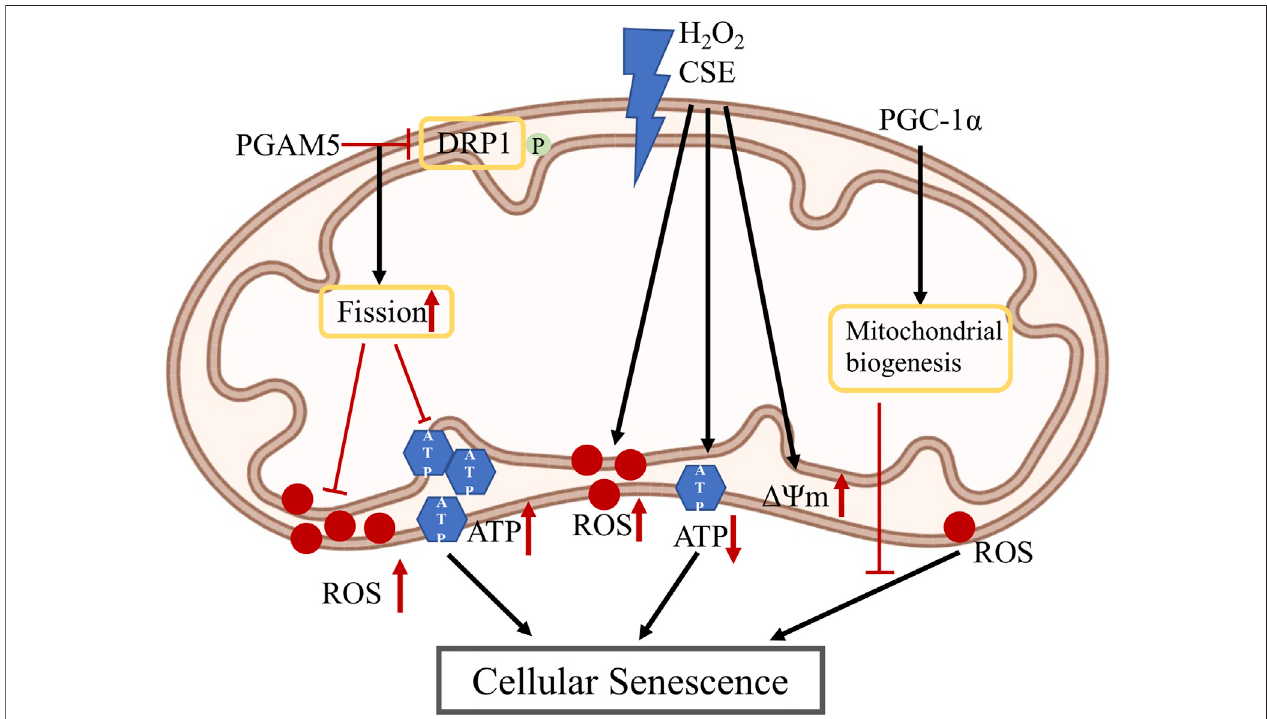
FIGURE3| MitochondriachangesinRPEsenescence:PGAM5dephosphorylatesDRP-1whichpromotesmitochondrial fi ssion,whichtheninhibitstheincreaseof ROS and ATP in RPE cellular senescence; H 2 O 2 and CSE induce increased mitochondrial ROS and membrane potential, also induce decreased ATP level which cause RPE cellular senescence; PGC-1 α is a master regulator of mitochondria biogenesis and could reduce ROS level which may inhibit RPE cellular senescence. PGAM5: phosphoglycerate mutase 5; DRP1: dynamin-related protein 1; H 2 O 2 : hydrogen peroxide; CSE: cigarette smoke extract; PGC-1 α : peroxisome proliferator- activated receptor gamma coactivator-1 α ; ATP: adenosine triphosphate; ROS: reactive oxygen species; ΔΨ m: mitochondrial membrane potential.